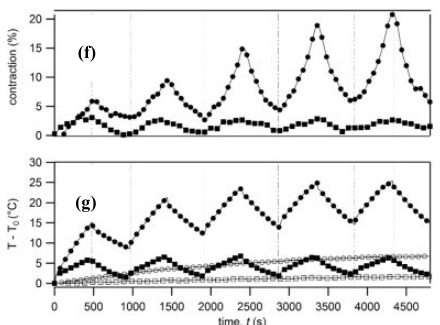
Figure 13. Thermal images of LCE-based composites with 0.5 wt% of iron-oxide nanoparticles when subjected to an alternating magnetic field of 48.24 kA/m and 298-kHz oscillating frequency at ( a ) 0, ( b ) 27, ( c ) 159, and ( d ) 926 s. ( e ) Superposition of the temperature (unfilled symbols) and contraction (filled symbols) profiles of the LCE composites with 0.5 wt% (●) and 0.7 wt% ( ■ ) of iron-oxide nanoparticles obtained in a magnetic-actuation experiment. Crosses in thermal images represent the reference points where the temperature data were collected using the infrared camera’s software. Mechanical deformation ( f ) and temperature increments ( g ) of LCE-based composites with 0.5 wt% of iron-oxide nanoparticles in response to an applied alternating magnetic field of 34.73 kA/m at 298 kHz over five eight-minute on/off cycles submerged in water ( ■ ) and in a model cell-growth medium (labeled DMEM; ●). Filled and unfilled symbols in the bottom figure correspond to temperatures measured close to the surface of the elastomer and at the bottom of the reservoir, respectively. T 0 corresponds to the initial temperature at t = 0. Reproduced with permission from the authors of [65]. Copyright © 2018